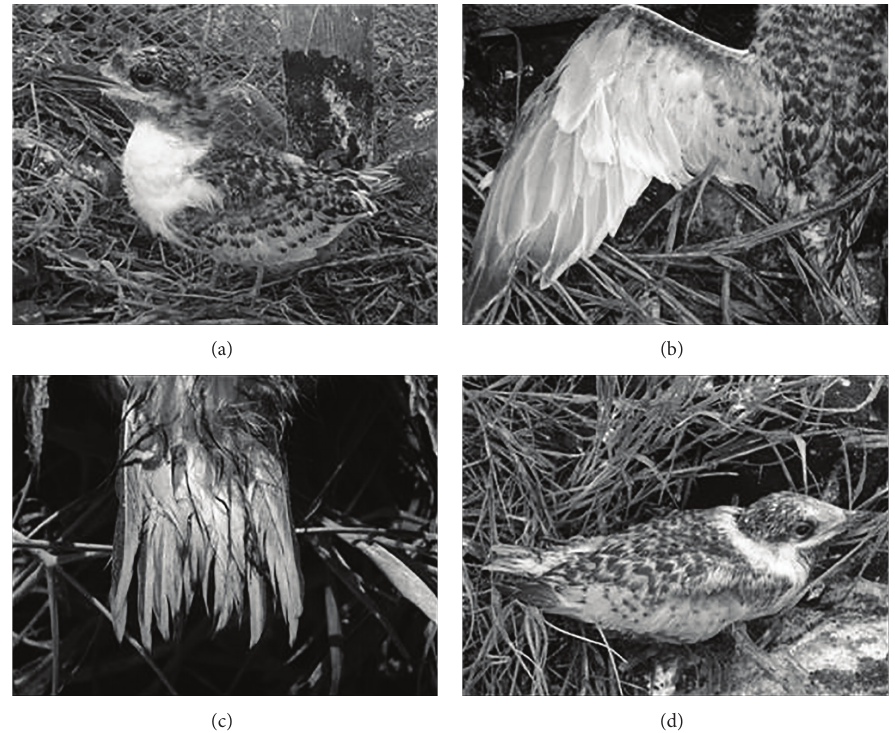
Figure 6: JIV of Sterna hirundinacea in the beginning of the phase (a), details of the cannon feathers on the remiges (b), rectrices (c), and end of the stage